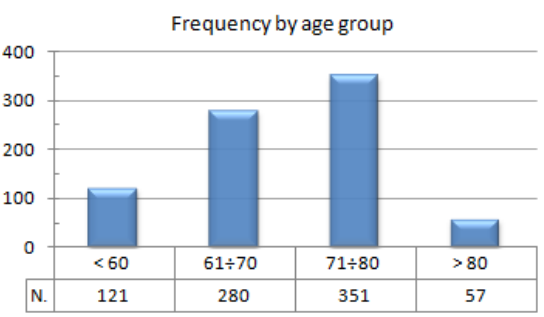
Figure 4. Guest distribution by age